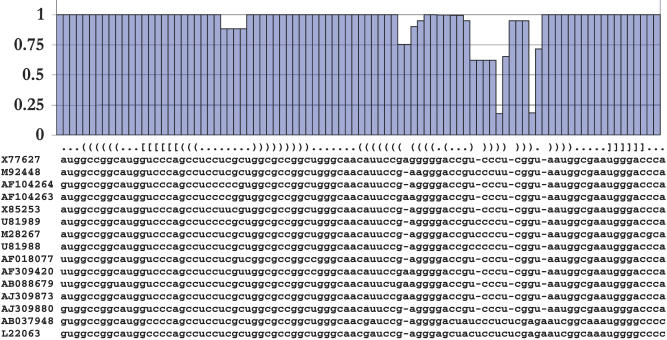
MPD Alignment for the HDV Dataset Consisting of 15 Sequences of HDV RibozymesThe name of each sequence indicates the NCBI accession number of the strain. The ribozyme contains one pseudoknot and a variable helix as shown in the line above the alignment, which denotes the known reference structure in dot-bracket, or Vienna, notation. The posterior probabilities for each alignment column were derived from the multiple sequence alignments that the MCMC method sampled and are indicated at the top of the figure.